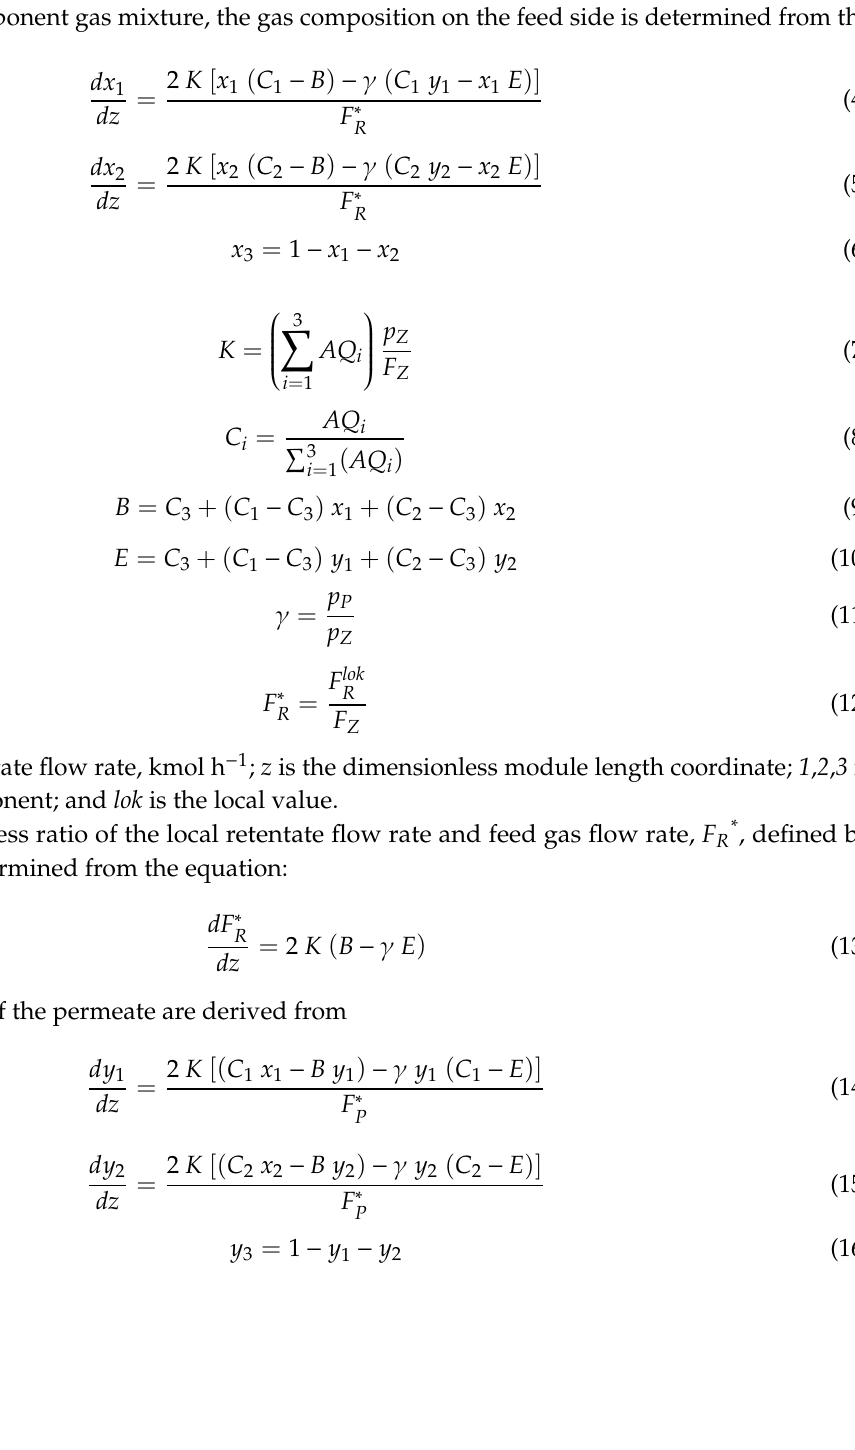
Figure 2. Gas streams in a membrane module for plug flow on the feed side and countercurrent plug flow on the permeate side.